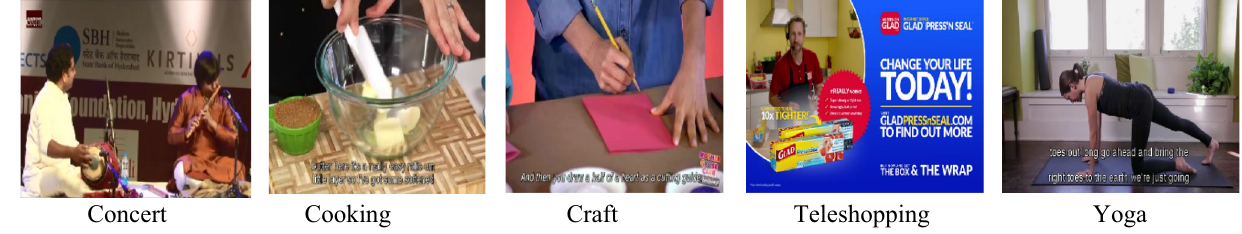
Fig. 6 Sample images of successful classification of the proposed modelon our dataset. Original Source: